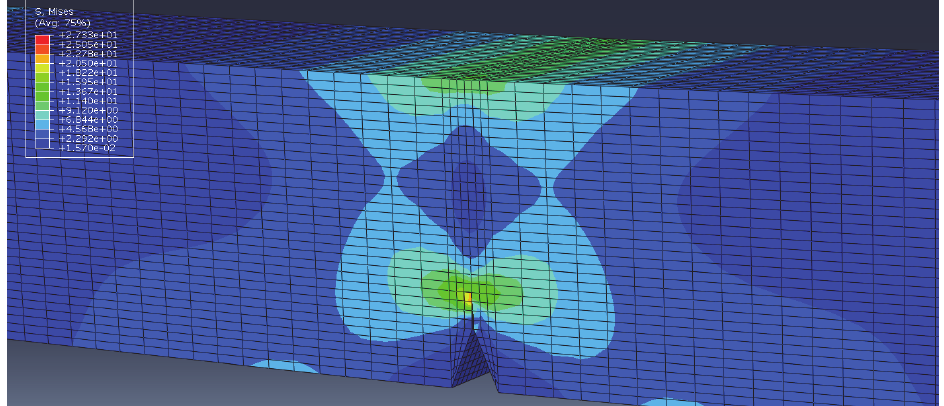
Figure 2: Step one - crack opening and Von Mises stresses at crack tip.